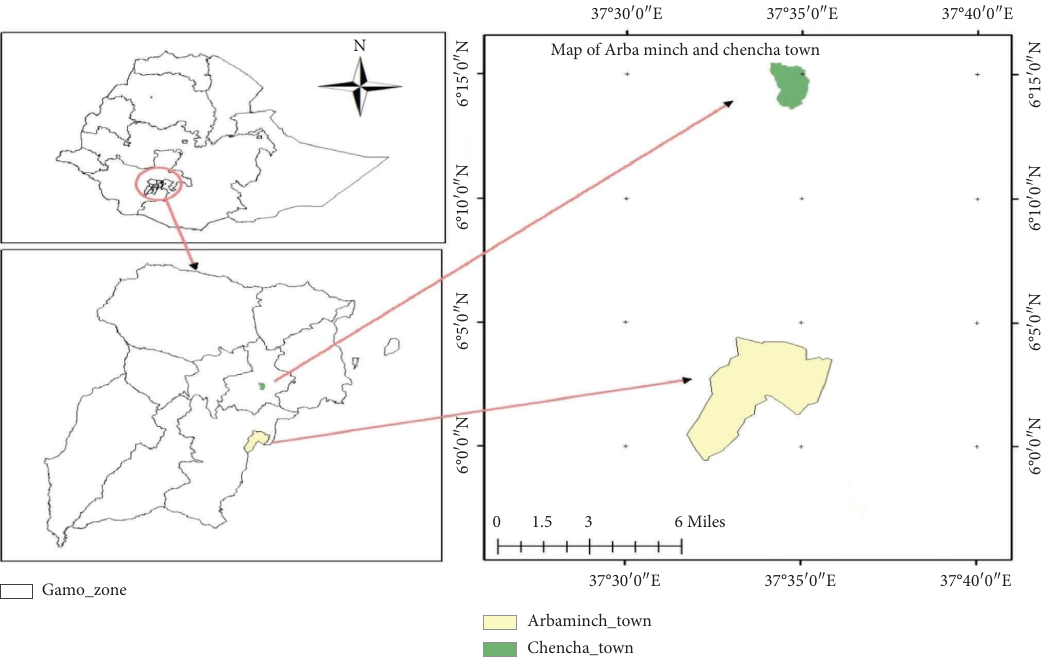
Figure 1: Map of study area (Gamo zone environment and forest protection